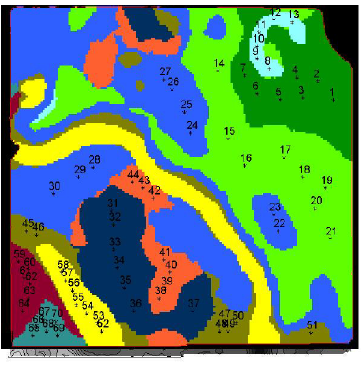
FIGURE 8. Zones and sampling points.